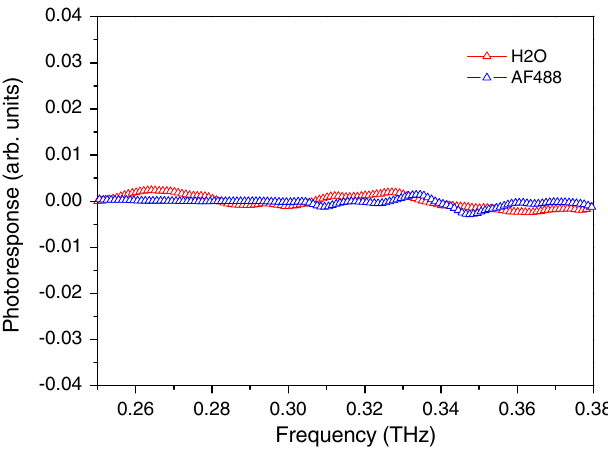
FIG. 9. Control data of the rectenna-based absorption spectra. We show the difference spectra obtained with and without blue laser illumination of water (red triangles) and of an aqueous solution of AF488 fluorochrome at a concentration of 5 mg = mL (blue triangles). The spectra have been recorded after 10 min of blue light illumination.